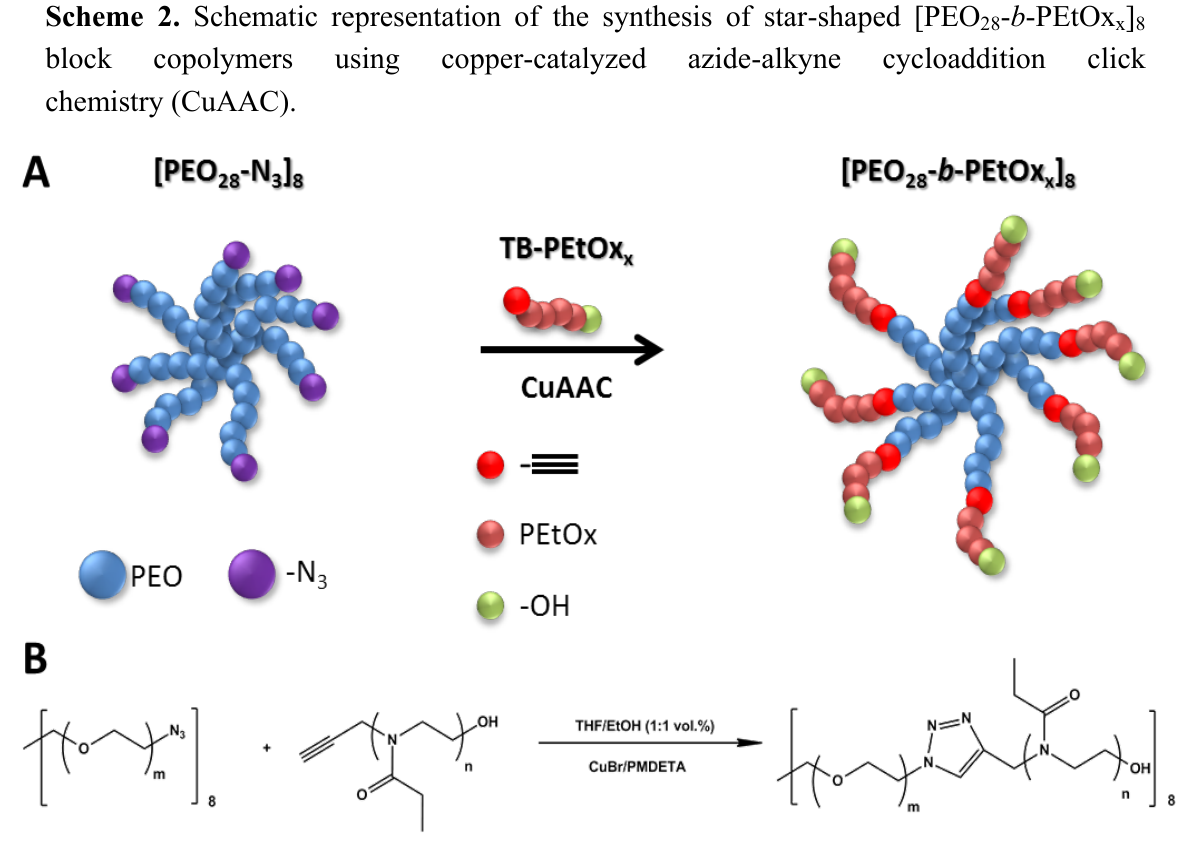
- b -PEtOx ] block 28 x 8